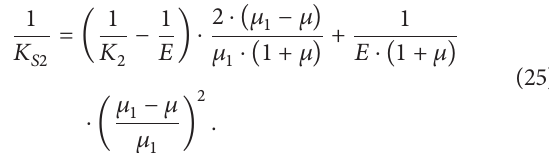
Figure 4. The structure is in plane-stress condition. For this case, all of the micromodels are the same and built at the position with 𝛼 = 45 ∘